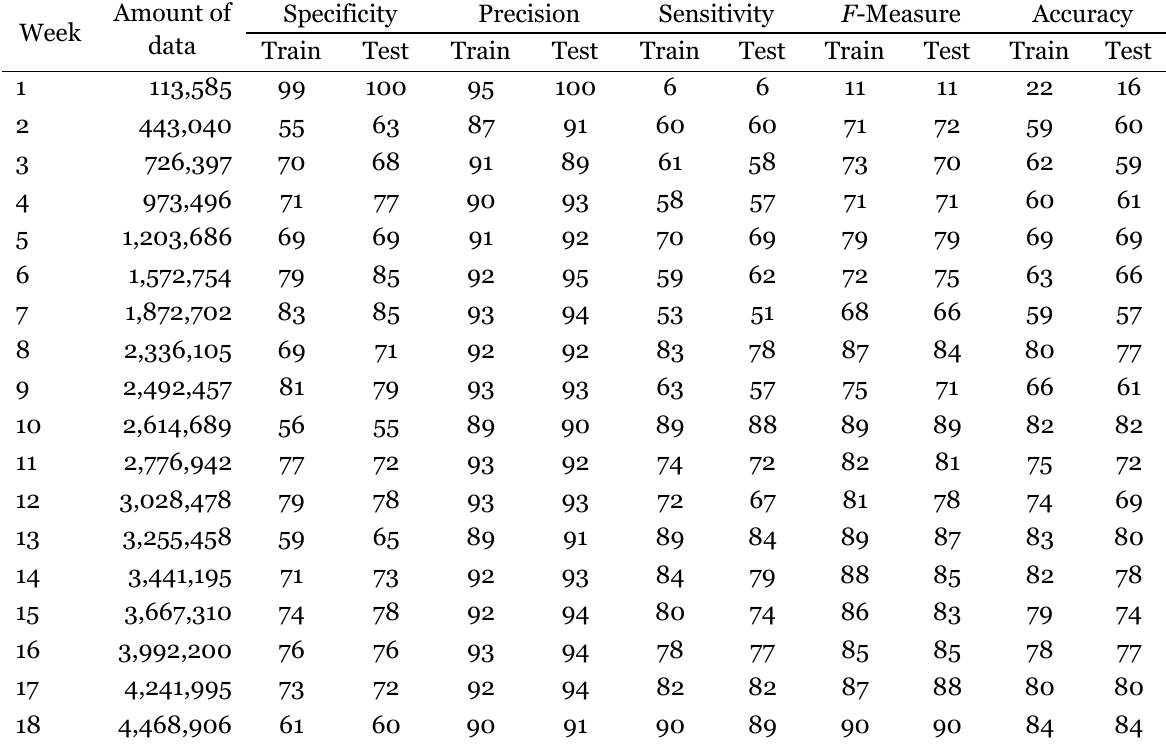
Specificity, Precision, Sensitivity, F-Measure, and Accuracy Results